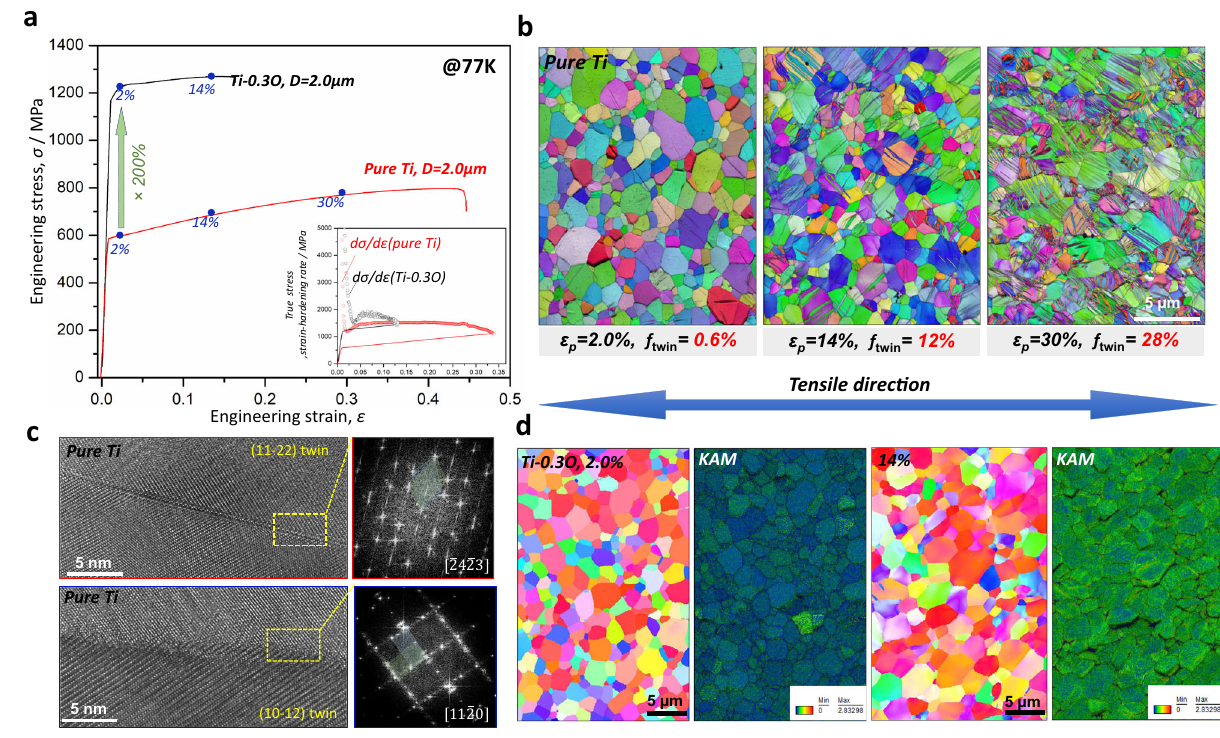
Fig. 4 | Mesoscopic deformation behavior of UFG pure Ti and Ti-0.3O at 77K. a Engineering stress-strain curves of UFG pure Ti and Ti-0.3O at 77K. The true stress-strain and strain-hardening rate curves of the two alloys are inserted. b IPF maps of UFG pure Ti at interrupted plastic strains of 2.0%, 14% and 30%. The fractions of deformation twins are much smaller than those in CG pure Ti. c High